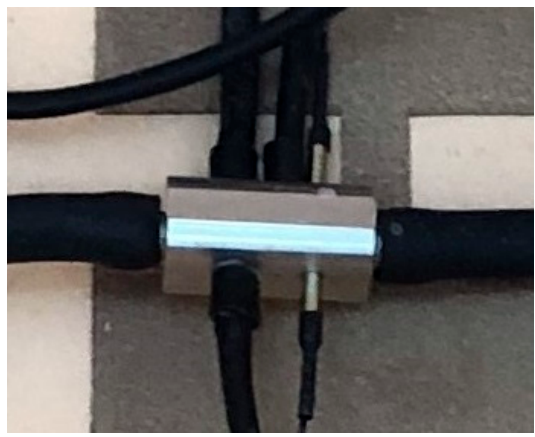
Figure 9. Photograph of the laser extinction sensor based on multichannel fiber-optic bundles shown schematically in Figure 8.